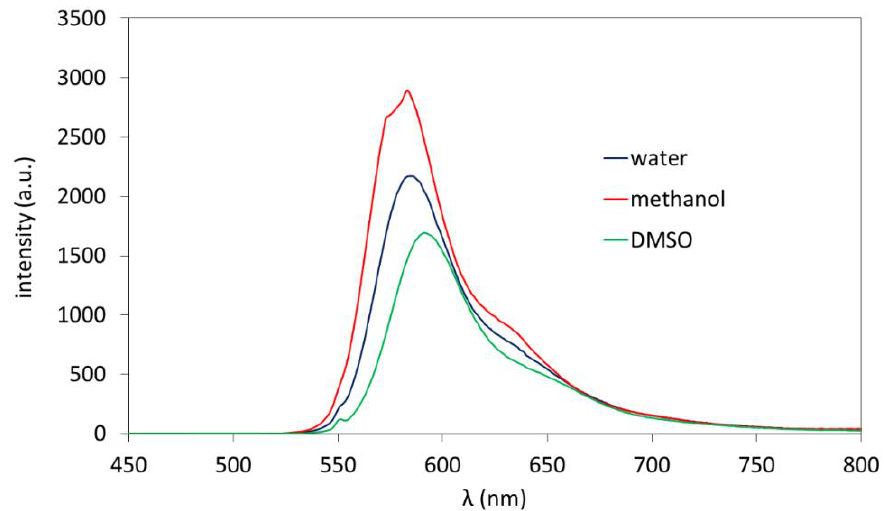
Figure 2. Emission spectra of RhB-PChMA in various solvents.